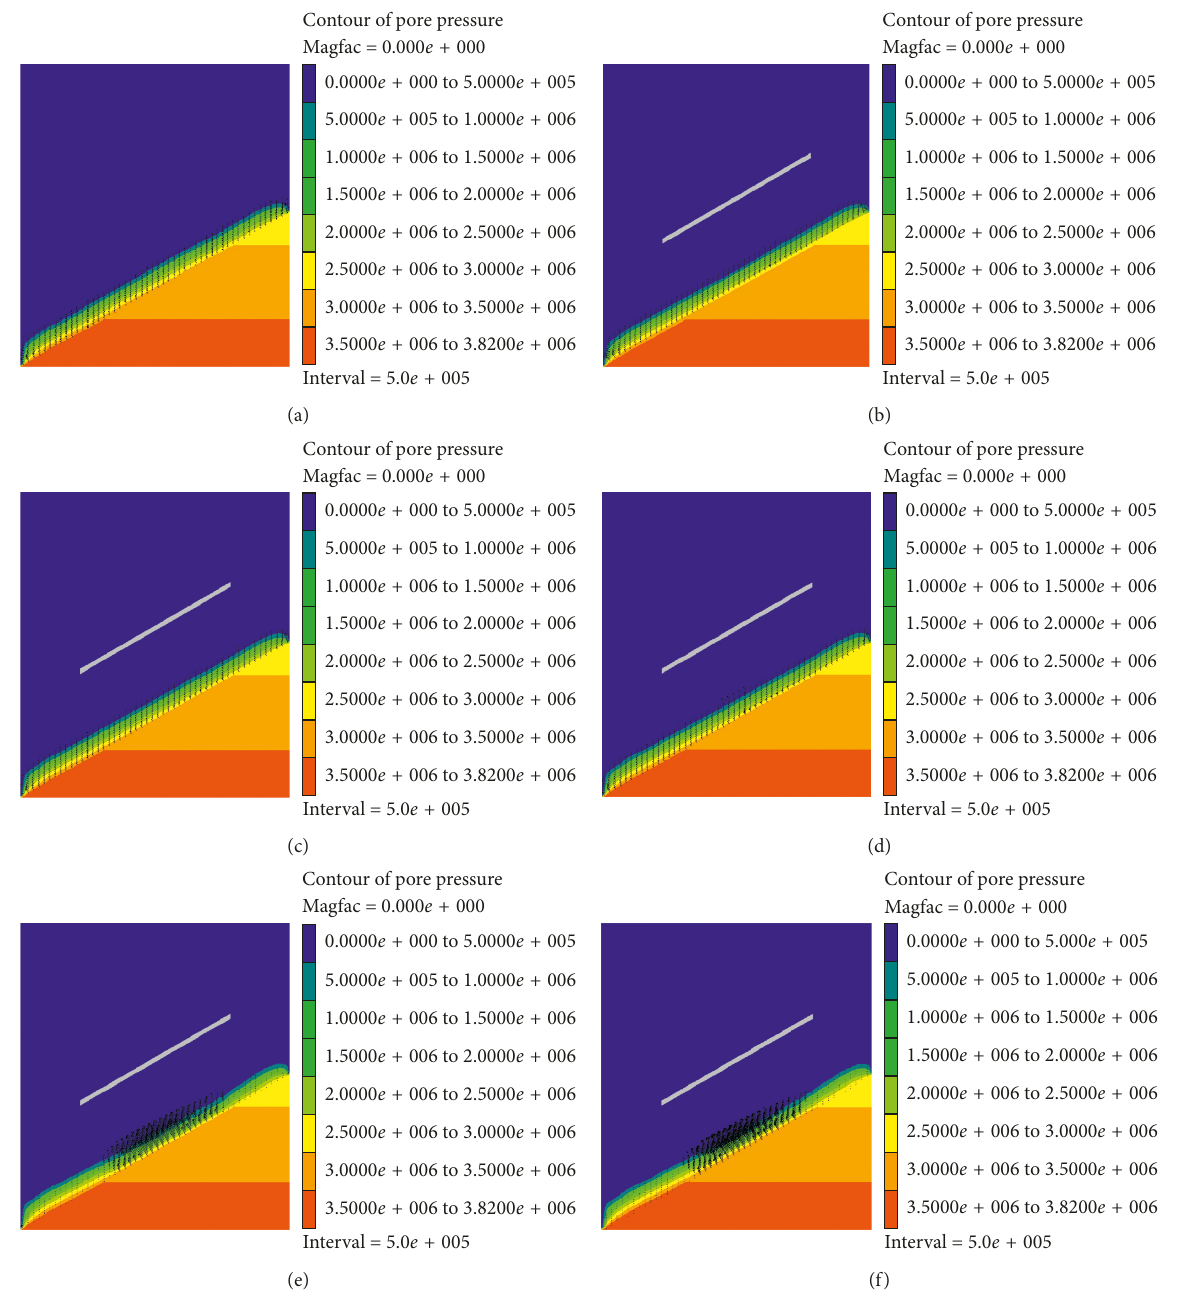
Figure 6: Pore water pressure and seepage vector distribution of workface floor along the inclined direction of the coal seam with the advancement of the workface (no water inrush). (a) Original pore pressure. (b) Advanced 20m of workface. (c) Advanced 40m of workface. (d) Advanced 60m of workface. (e) Advanced 80m of workface. (f) Advanced 100m of